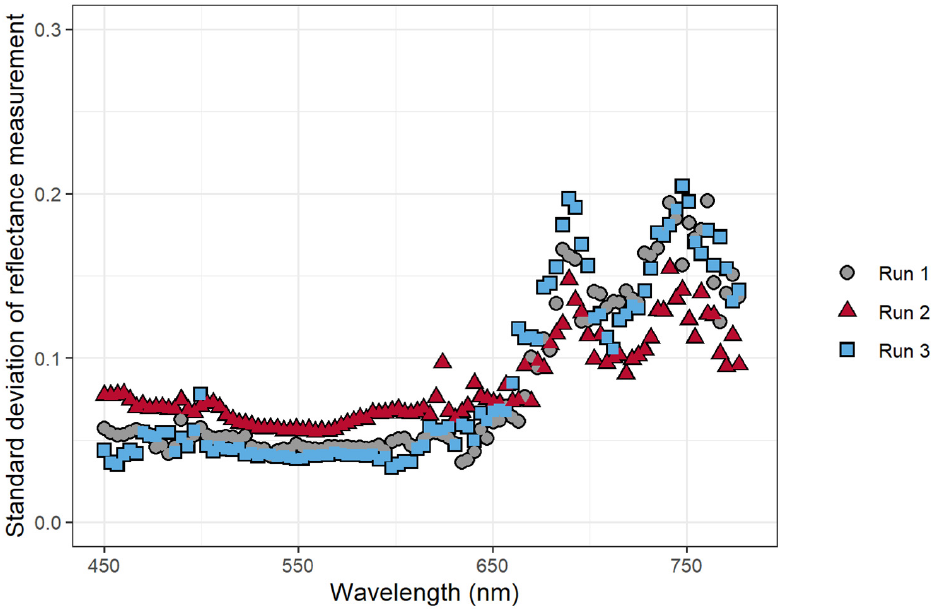
Figure 3. The effect of atrazine application on the standard deviation of the normalized average reflectance/fluorescence of Catharanthus roseus as a function of the wavelength. Data used to calculate the standard deviation was taken every 15 min after herbicide application for 8 h (n = 32).